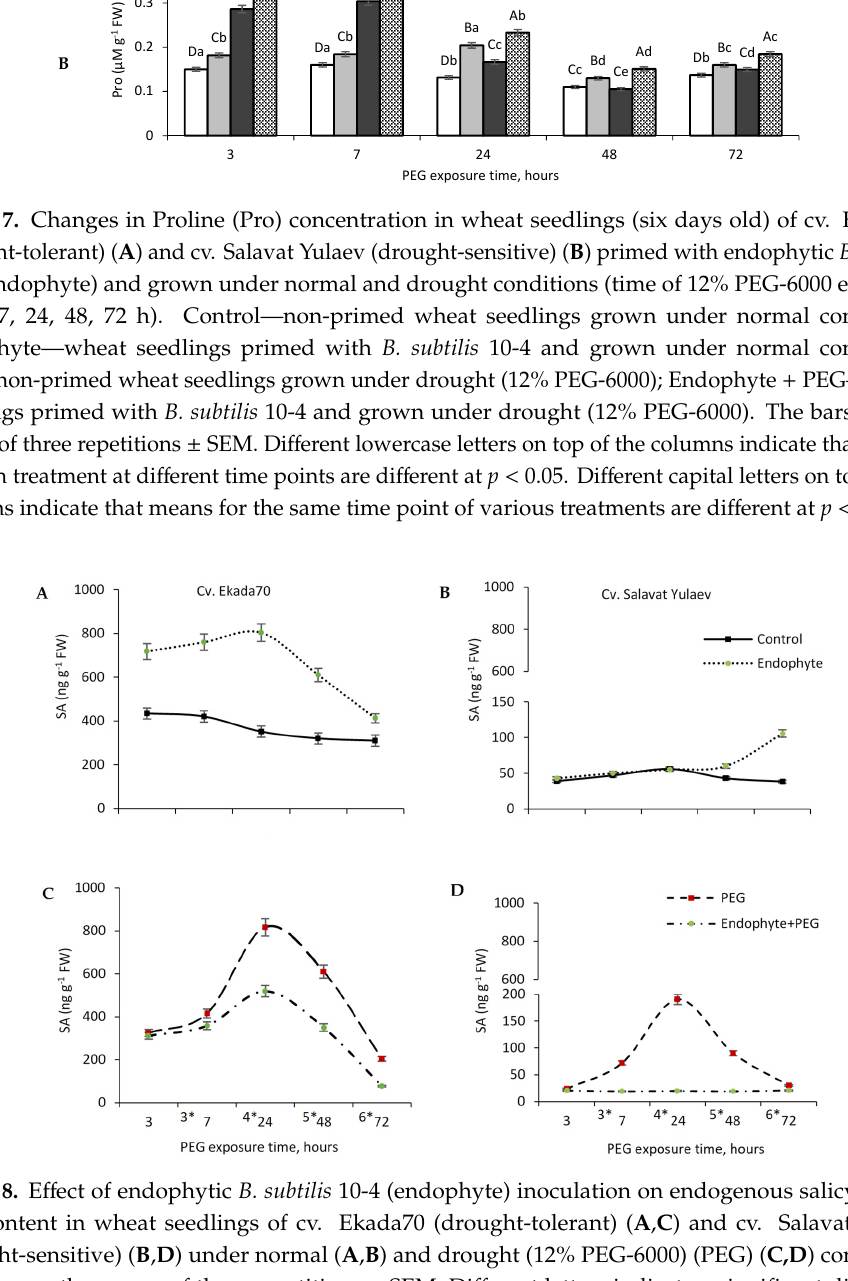
DbCb Cb Da Da Db